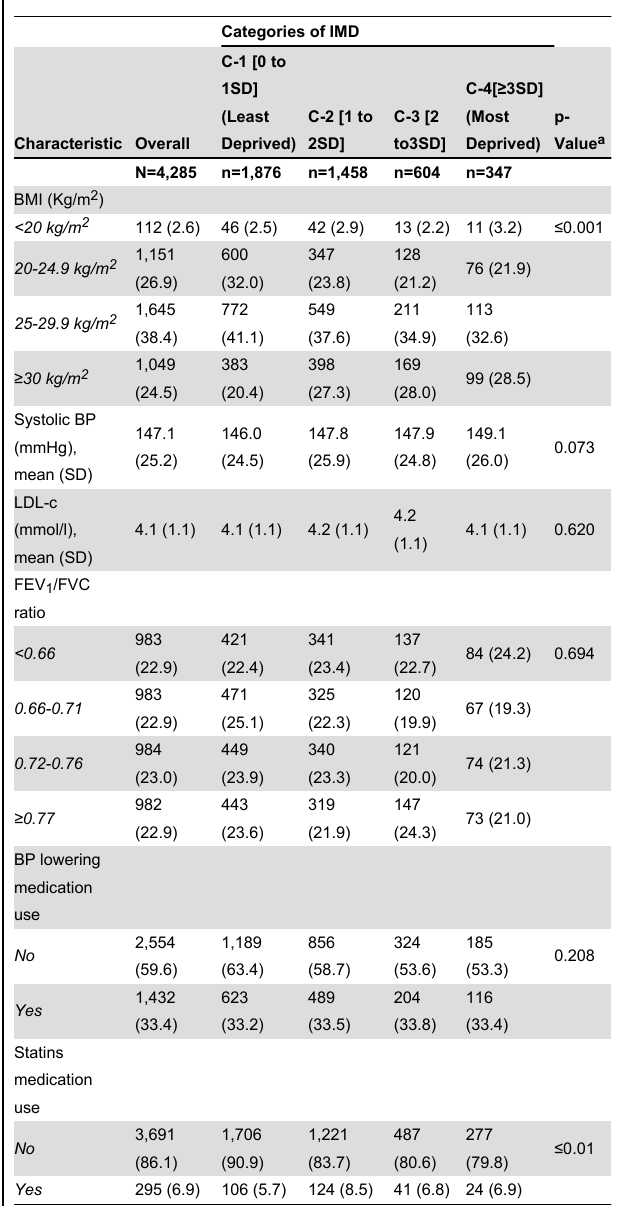
Table 2. Biological factors and self-reported use of cardiovascular medication across categories of the